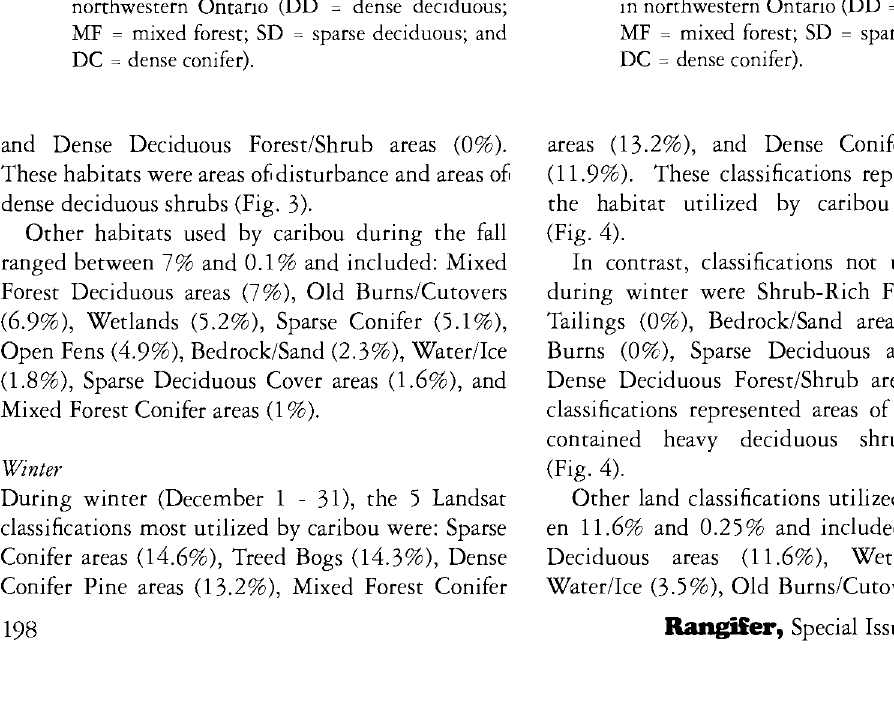
Fig. 3- Percentage of point locations in different Landsat land cover classes for woodland caribou during the fall of 1995 (September 1 - November 31) in northwestern Ontario (DD = dense deciduous; MF = mixed forest; SD = sparse deciduous; and DC = dense conifer).